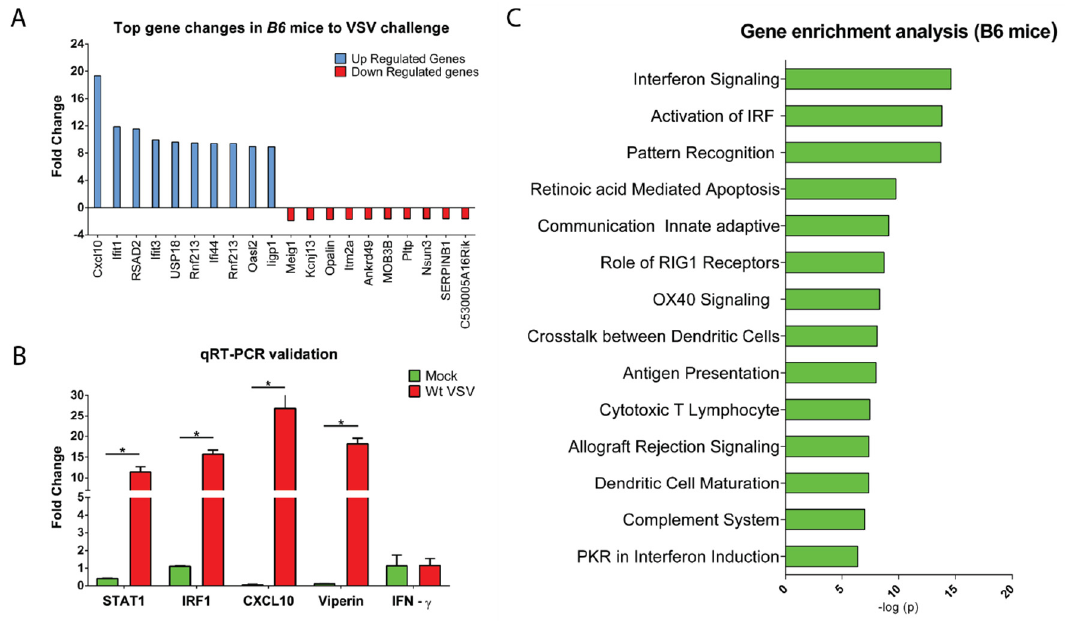
Figure 3. VSV infection in the brain induces IFN-I-driven antiviral response. Microarray analysis was performed on the total RNA extracted from the mice brain ( n = 4) tissue at day three post-infection and compared to the mock-infected mice. ( A ) A representative bar graph showing the top 10 di ff erentially expressed gene candidates (blue represent upregulation while red represent downregulation). ( B ) Few selected genes falling to the category of antiviral response (STAT1, IRF-1, CXCL10, IFN- γ , and Viperin) were validated by RT-PCR experiments. The fold change in gene expression was calculated by normalizing the data with the housekeeping gene ( β -actin) as an internal control from the same sample using ∆∆ Ct method. * denotes p -value < 0.05. ( C ) Ingenuity pathway analysis tool was used to predict the top biological canonical pathways corresponding to the gene expression profile and are represented here in the bar graph. The negative log p values are plotted on the graph X